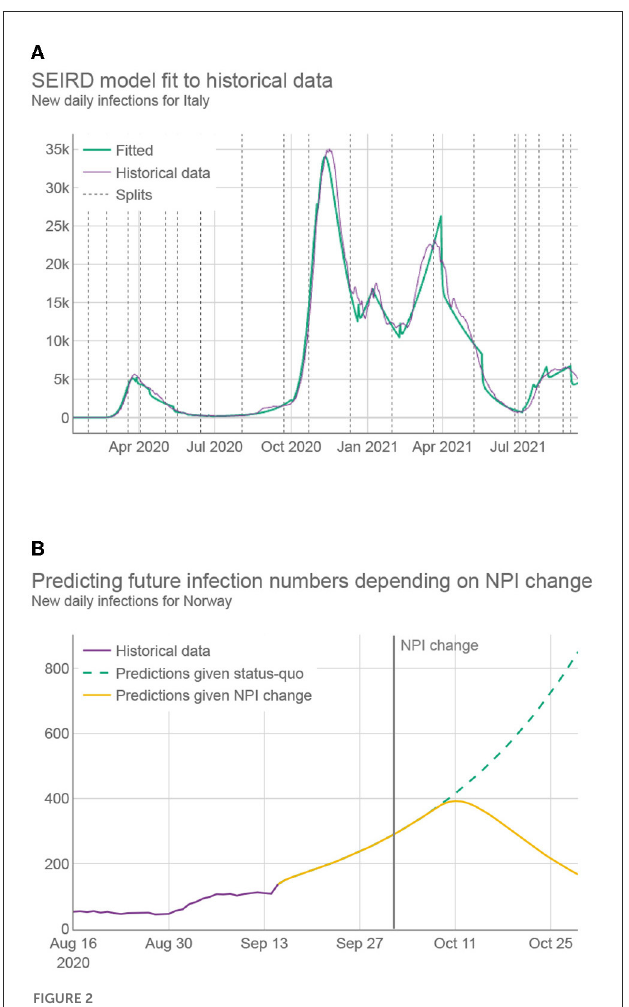
FIGURE2 (A) Daily infections for Italy over 20 months (purple) together with the predictions using best fitted SEIRD model (green). Fitting was conducted by first splitting the data into segments, represented by dashed vertical lines, where at least two NPIs were changed with respect to the previous segment. Different segments use different fitted parameters. (B) Daily infection predictions for Norway, made both by using only fitted parameters (green) and by using parameters adapted by machine learning, which reflect the change to more strict NPIs (yellow).